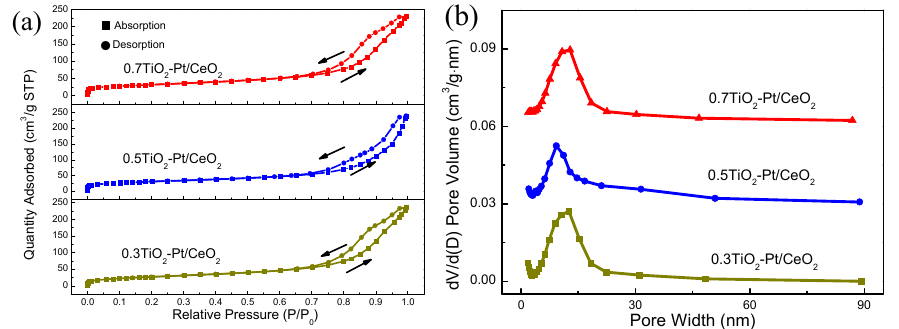
Figure 5. ( a ) Nitrogen adsorption–desorption isotherms and ( b ) the BHJ pore size distribution of (TiO 2 − Pt)/CeO 2 .